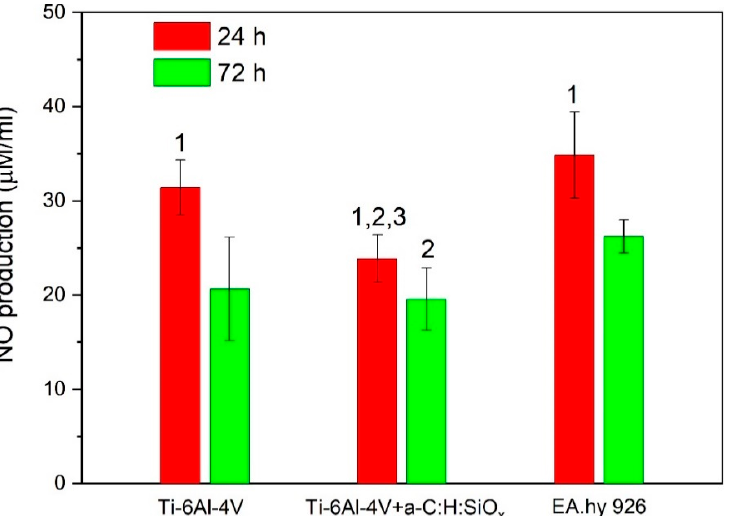
Figure 10. NO production by EA.hy926 cells cultured on substrates: 1—24 h vs. 72 h ( p < 0.01), 2—T2 vs. EA.hy926 cells on culture plastic ( p = 0.01), 3—T2 vs. T1 ( p = 0.02). Data are presented as mean ± SD. Six measurements were performed in each group. Control-EA.hy926 cells cultured on plastic.